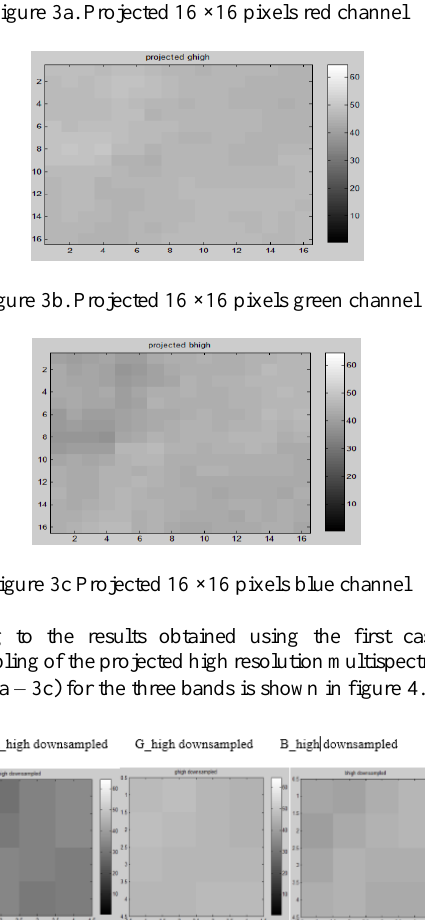
Figure 4. Downsampled 4 × 4 pixels multispectral data based on first case.